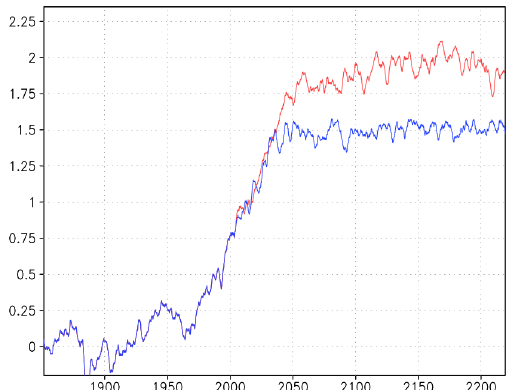
Figure 2. Time evolution of the global-mean near-surface tempera- ture response in the Hist1 experiment (1850–2005; blue) and the CPL-15 (2006–2230; blue) and the CPL-20 experiments (2006– 2230; red) relative to pre-industrial conditions (years 1850–1852). A 3-year running average is used for both curves. Units are in de- grees